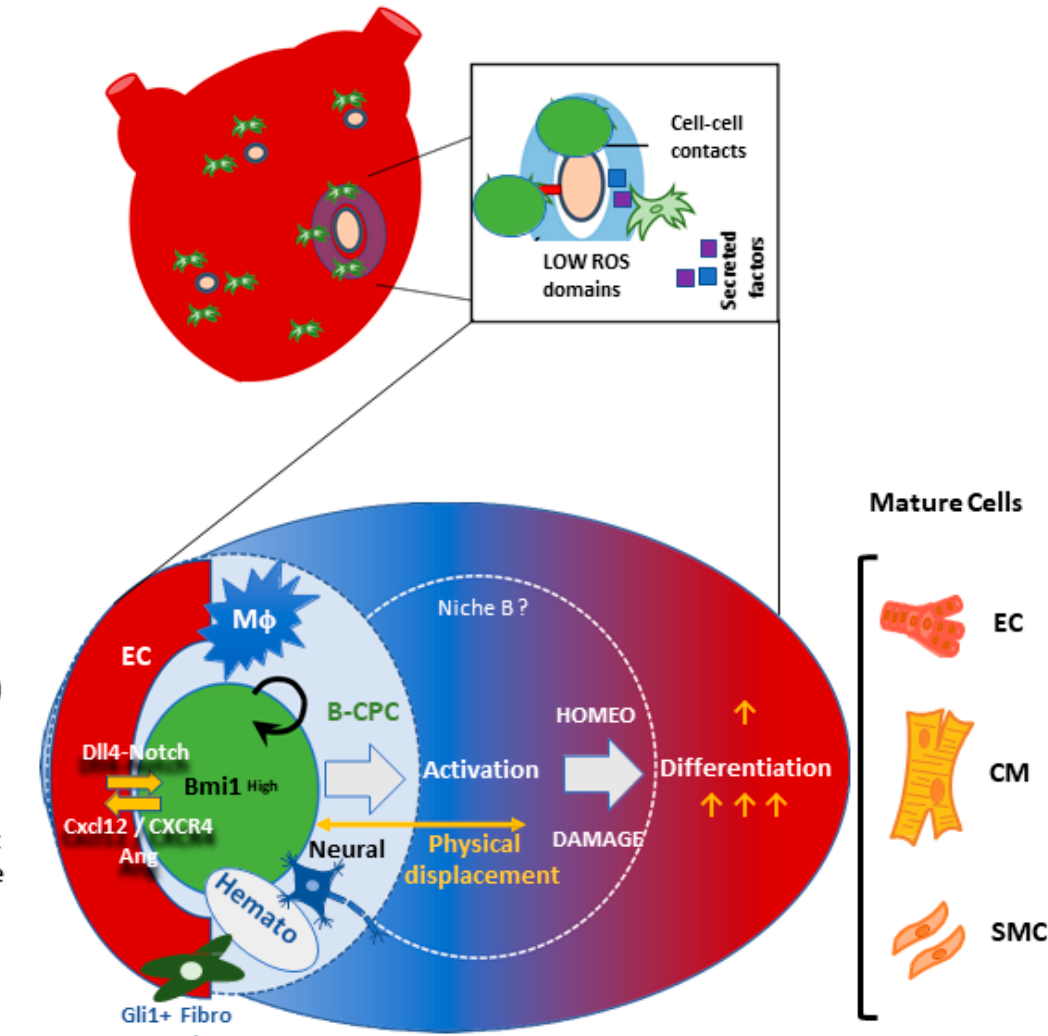
Figure 5. The vascular niche for cardiac B-CPC. Working model for the differentiation of B-CPC driven by ROS levels. The B-CPC are mainly confined to low-ROS perivascular spaces. They are regulated by modifications of ROS levels, cell–cell contacts, and secreted factors. B-CPC closer to the cardiac endothelium (EC), most in direct contact (B-CPC high ), are highly preferential in quiescence, show lower levels of total and mitochondria ROS, and are more protected against oxidative stress. The demonstrated EC/B-CPC pathways (Dll4 ⇒ Notch) and (CXCR4/angiogenesis ⇐ CXCL12) are indicated. Gli1+ fibroblastic progenitors have also been mapped in the same niches. Those cell types that are supposed to be involved in vascular niche regulation but not yet confirmed are denoted by blue symbols. M Φ , macrophages; Neural, sympathetic neural fibers; Hemato, BM-derived cells. Mature cells: cardiomyocytes (CM), smooth muscle cells (SMC) and endothelial cells